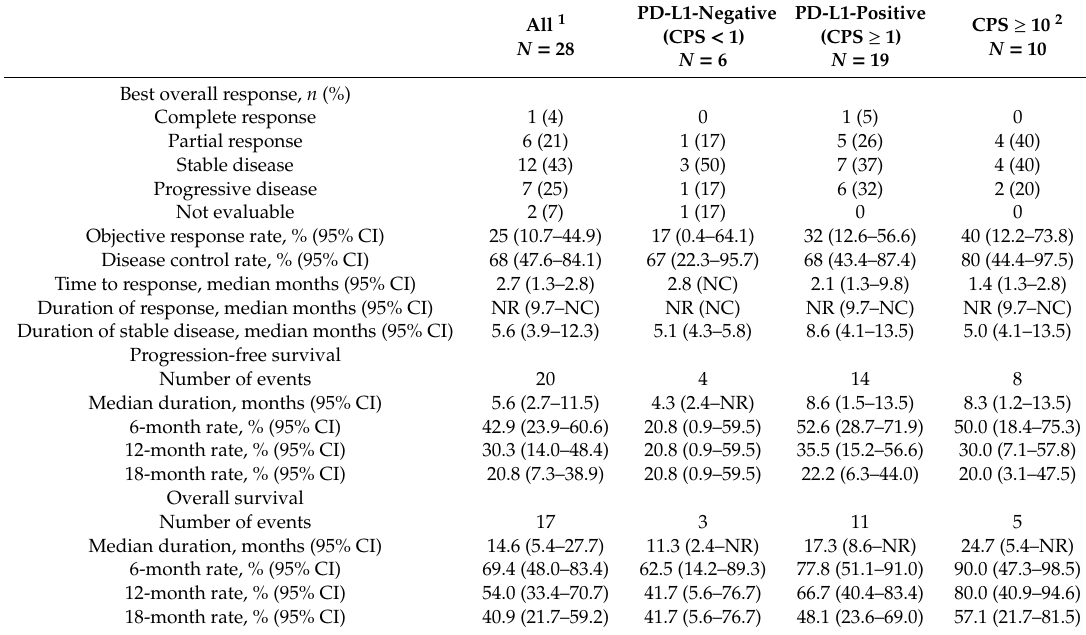
Table 3. Response, as confirmed per RECIST, and